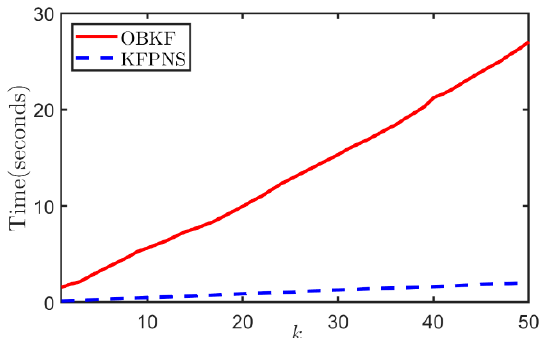
Figure 13. The time consumption of two algorithms when the length of the observation sequence changes. quence